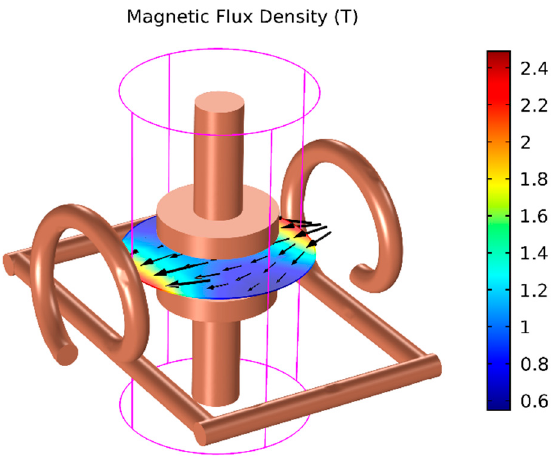
Figure 8. Distribution of the magnetic flux density amplitude generated by an electric current of 200 kA with 1 µSec rise-time.